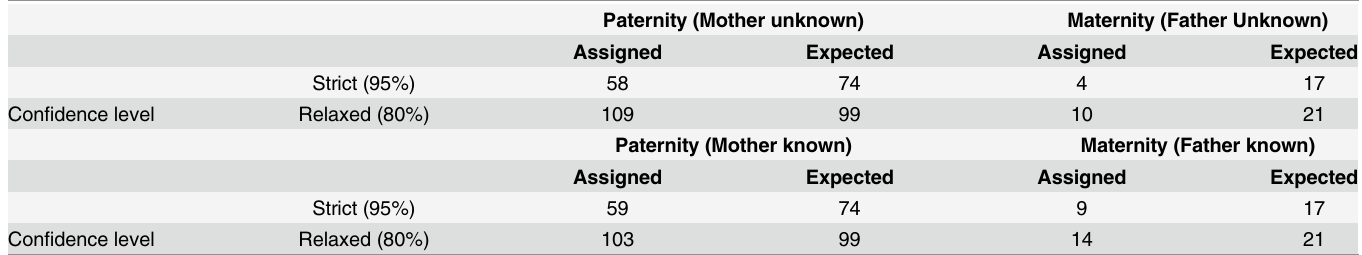
Table 1. Summary of parentage assignment estimates. Results of paternity and maternity analysis are listed, along with the expected estimates at two confidence levels. Results include analysis where parents were unknown as well as those where a known parent was